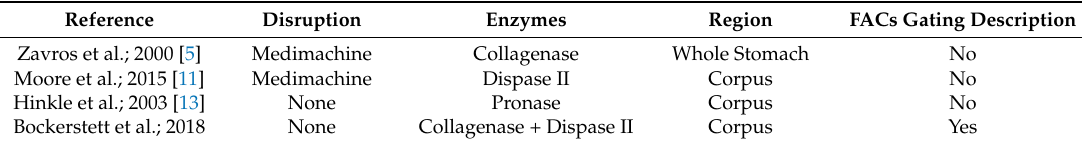
Table 1. Comparison of Methods for Generating Single Cell